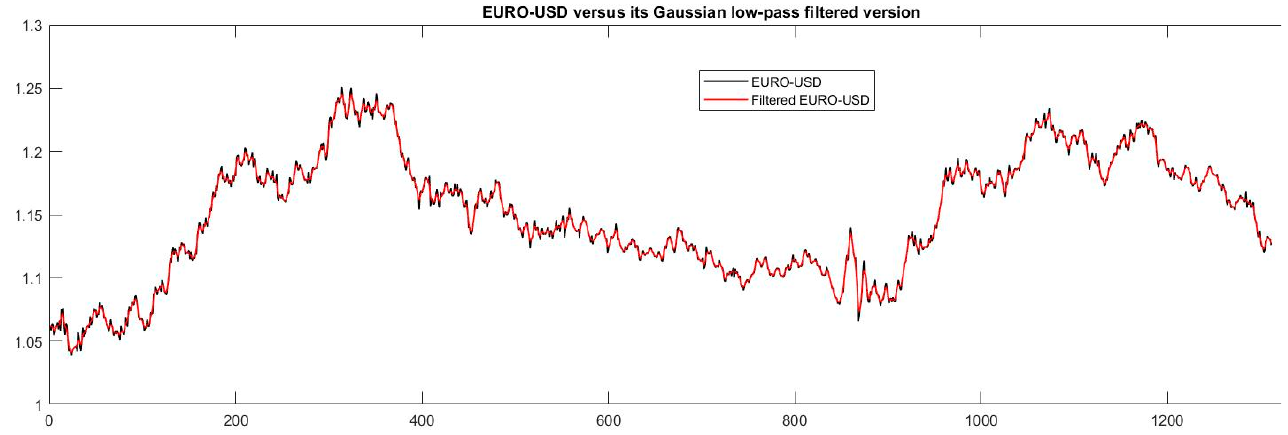
Figure 25. EUR–USD data set versus its filtered version.